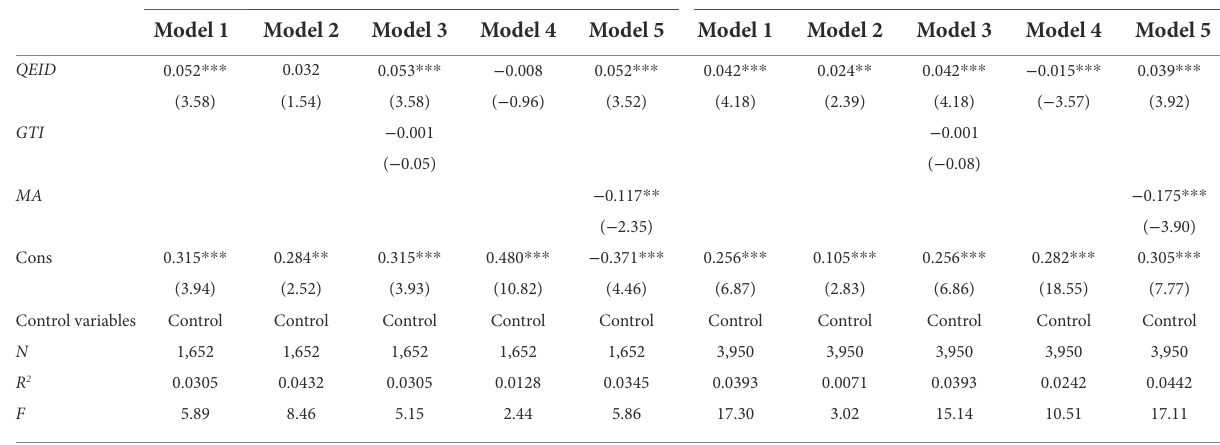
TABLE 7 Regression results of different property